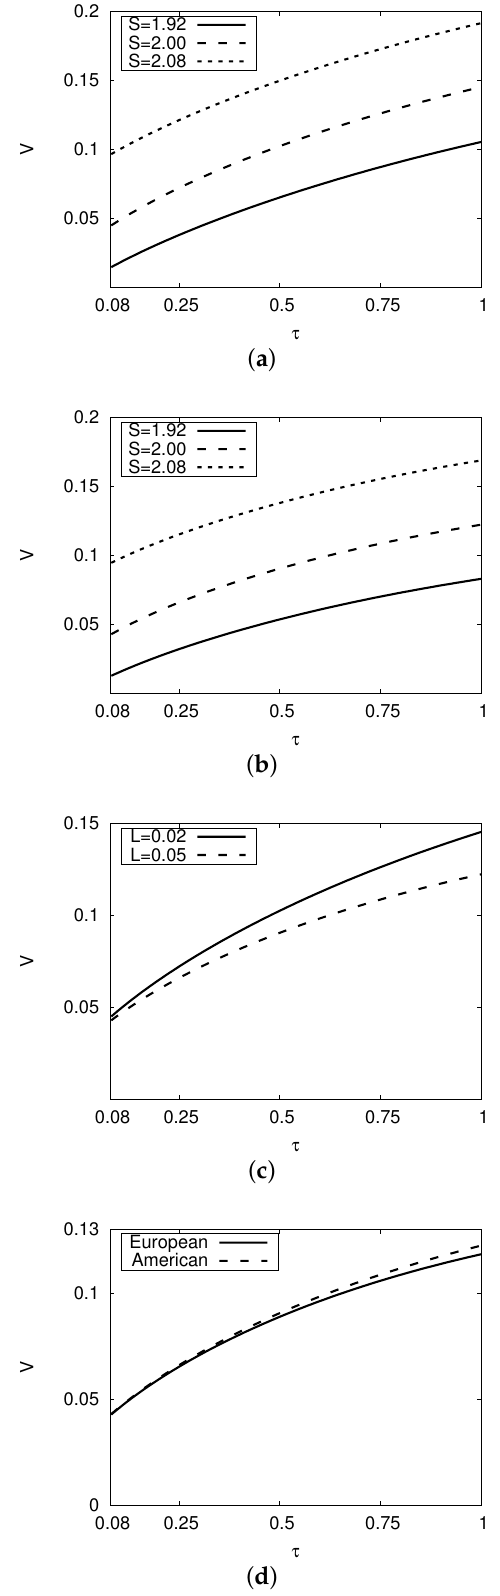
Figure 3. ( a ) American CI call ( V ) values with L = 0.02, ( b ) American CI call ( V ) values with L = 0.05, ( c ) American CI call ( V ) values with S = 2 and ( d ) European and American CI call ( V ) values with L = 0.05 for various expiries ( τ ). Parameters used: r = 0.05, q = 0.04, σ = 0.2, X =